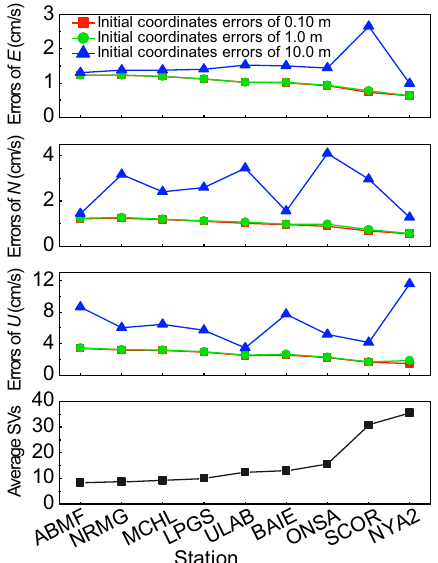
Fig. 6 RMSEs of LEO velocity determination in the east (E), north (N), and up (U) directions with 0.1 m, 1 m, 10 m initial position errors and the average number of available LEO satellites at nine MGEX stations